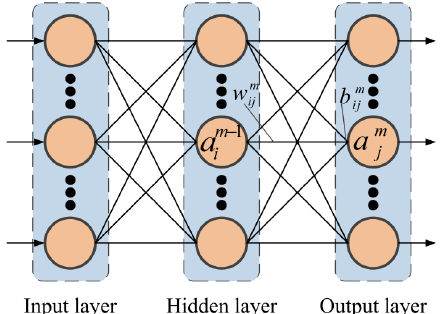
Figure 4. The structure of BP neural network.